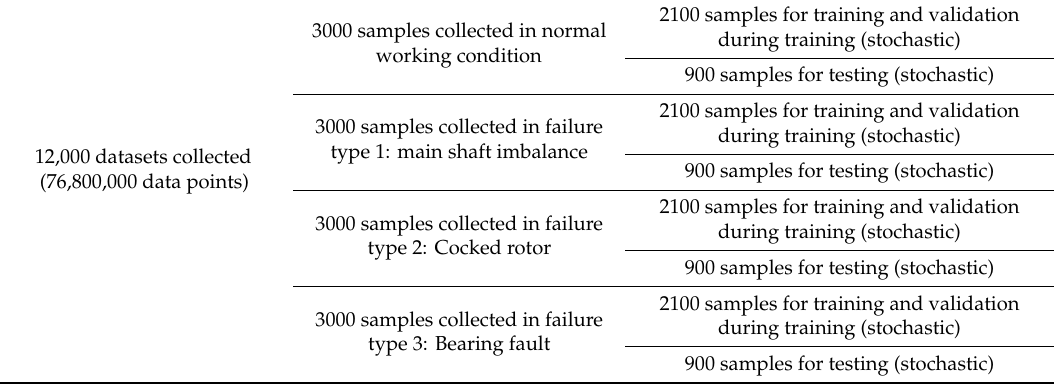
Table 2. Composition of collected samples for fault